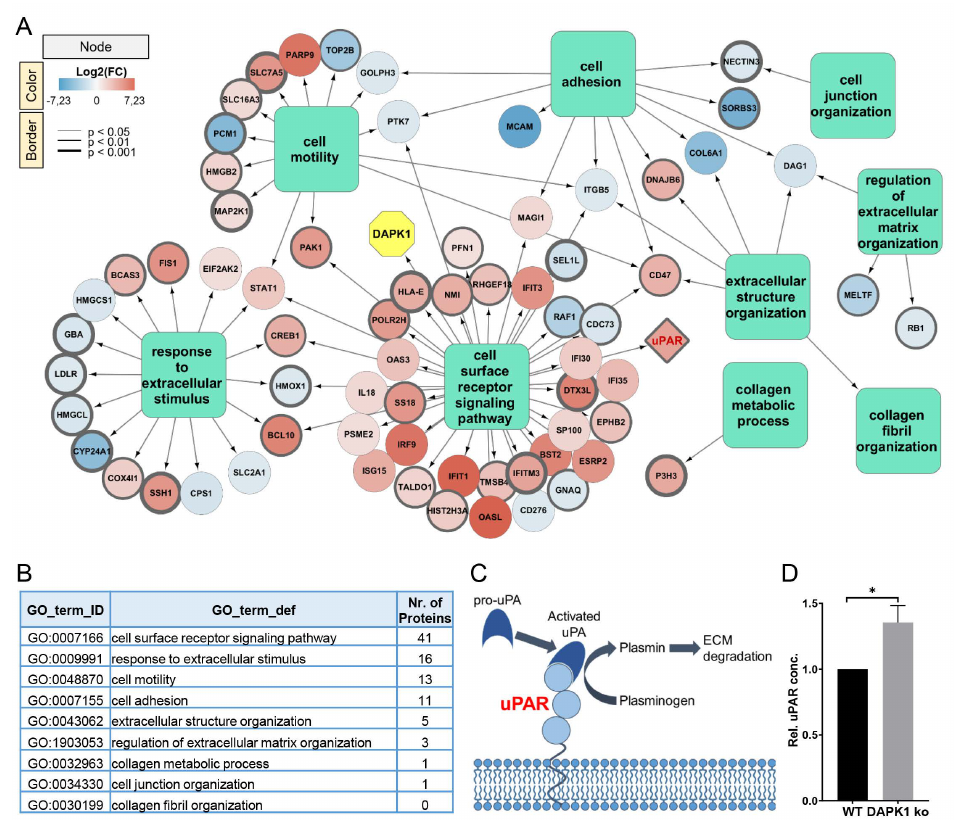
Figure 2. DAPK1-dependent proteomics signature. ( A ) GO-term network of all 70 proteins annotated with a GO-term subset. The node color, ranging from blue to red, represents the log2(FC) value of the respective protein, whereas the thickness of the node border represents the p -value. The node for DAPK1 (yellow) was added manually to the analysis. ( B ) GO-term IDs and definitions of the selected GO-term subset including the number of annotated proteins. ( C ) Schematic representation of the role of uPAR in the plasminogen-signaling cascade resulting in ECM degradation (Figure adapted from Brungs et al., 2017 [34], CC-BY for unrestricted use). ( D ) Validation of uPAR up-regulation upon DAPK1 loss in HCT116 WT cells using an ELISA assay (Mann-Whitney test: * p < 0.05). Data represented as mean ±